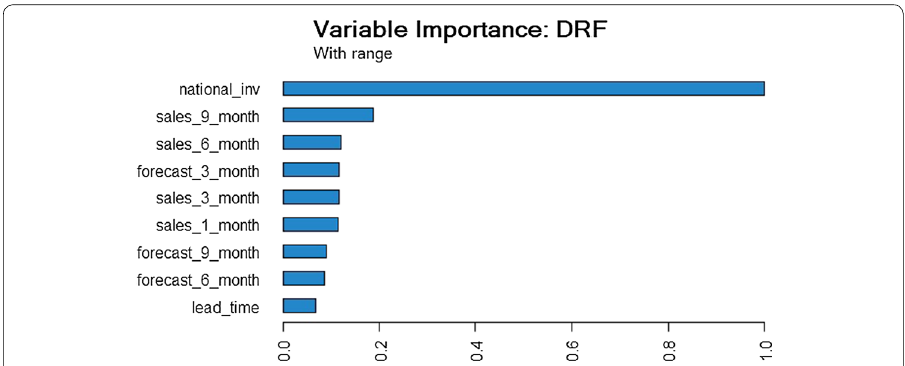
Fig. 6 DRF model’s important features with range converted data